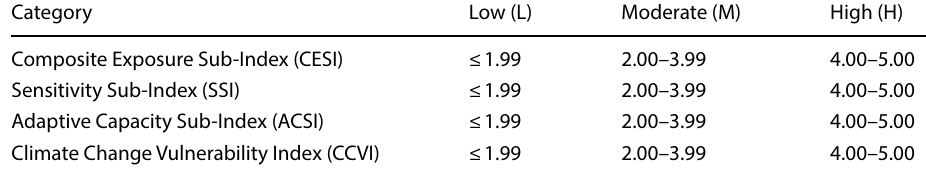
Table 3 Scoring and rating for the